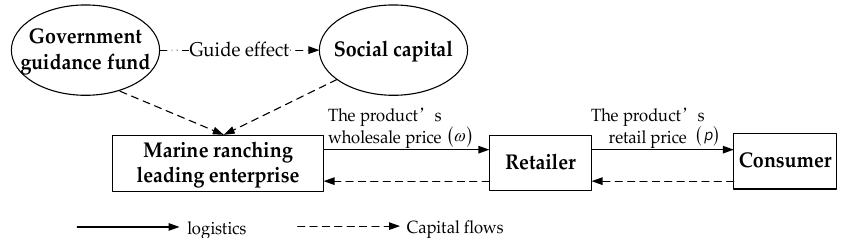
Figure 1. Basic model of marine ranching supply chain under government guidance